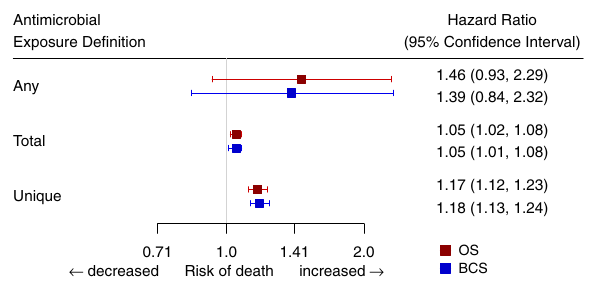
Fig. 1 | Forest plot of multivariable-adjusted hazard ratios (HRs) and 95% con- fi dence intervals for any, total, and unique antimicrobial exposures in the marginal structural Cox proportional hazards multivariate model (MSM) for N =772 independent patients. Data are presented as the HRs±95% con fi dence intervals, re fl ecting the risk of death for any antimicrobial use, de fi ned as ever versus never receipt of antimicrobials, and the risk of death for each change in the cumulative number of per-month prescriptions for total and unique exposures during observation. MSMs were adjusted for the following variables: age at diag- nosis, race, ethnicity, socioeconomic status quintile, cancer stage, tumor grade, receipt of chemotherapy, receipt of radiotherapy, ever use of growth factor sup- port, and surgery